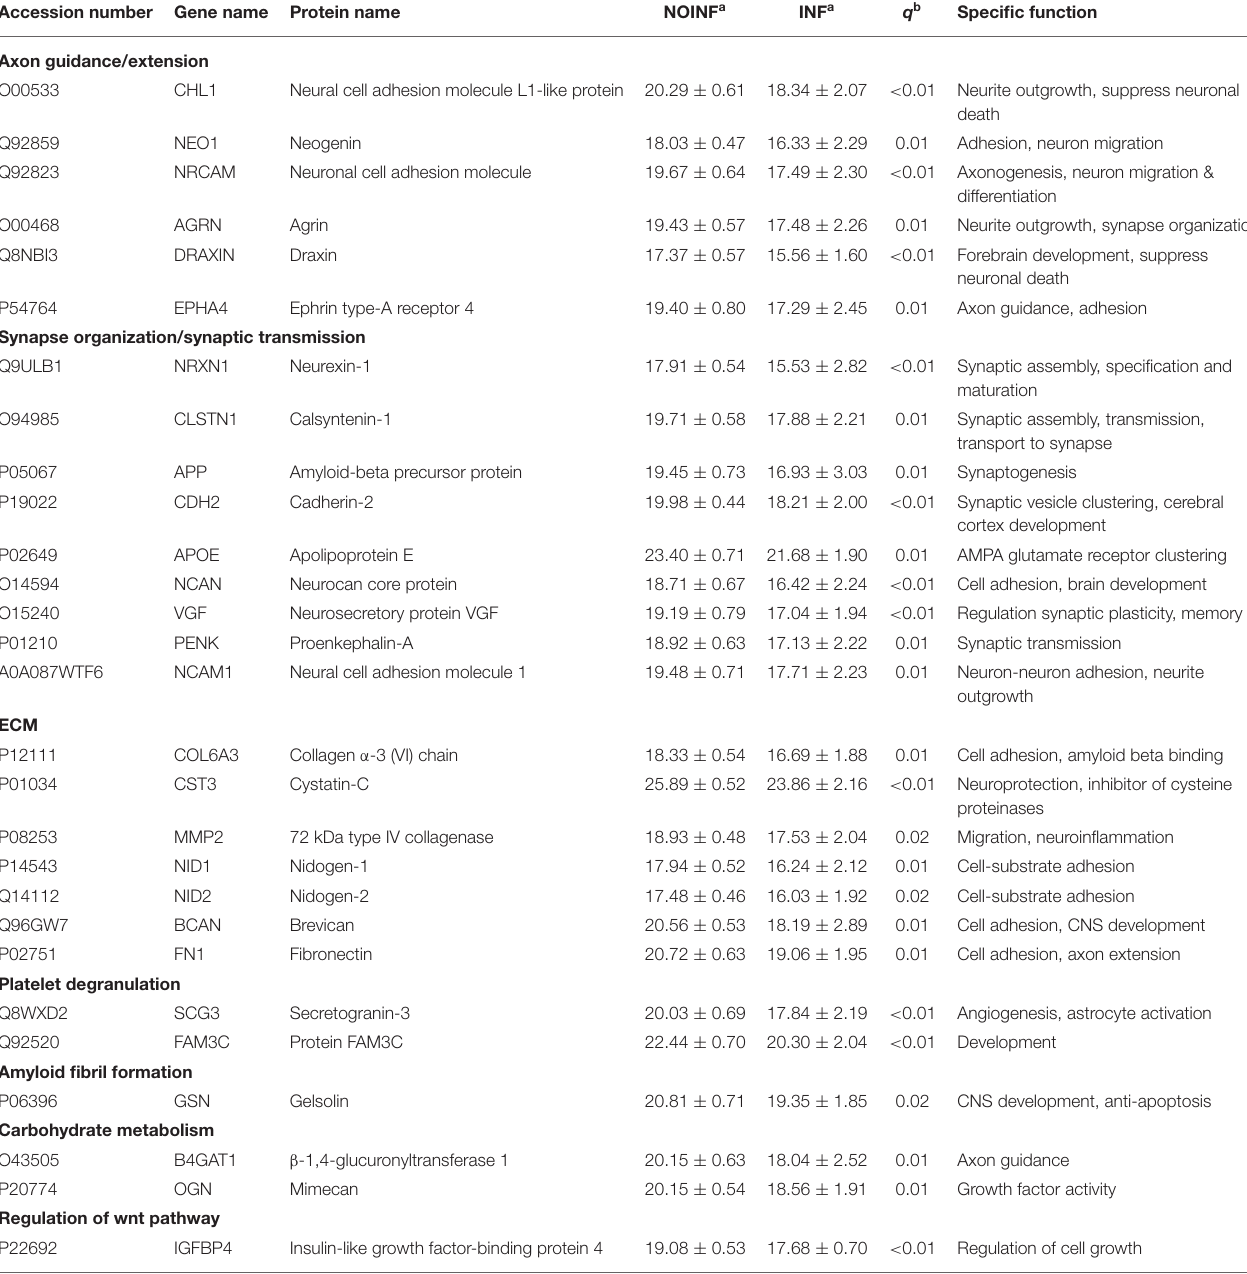
TABLE 2 | Selected proteins with differential abundance between the INF and NOINF groups. Accession number Gene name Protein